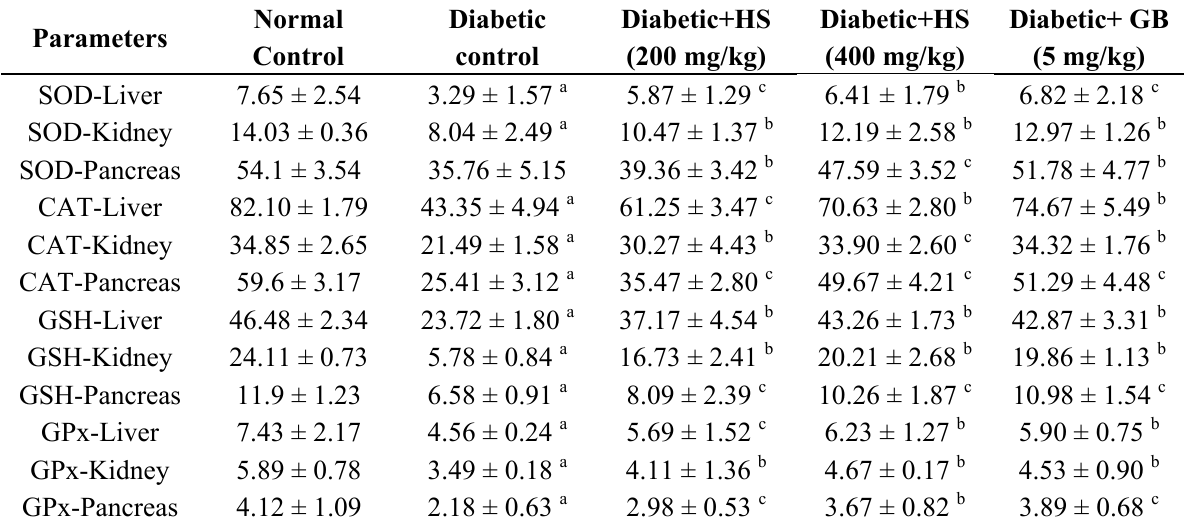
Table 1. Changes of superoxide dismutase (SOD), catalase (CAT), glutathione peroxidase (GPx), and glutathione reductase (GSH) in liver, pancreas and kidney in diabetic rats treated with